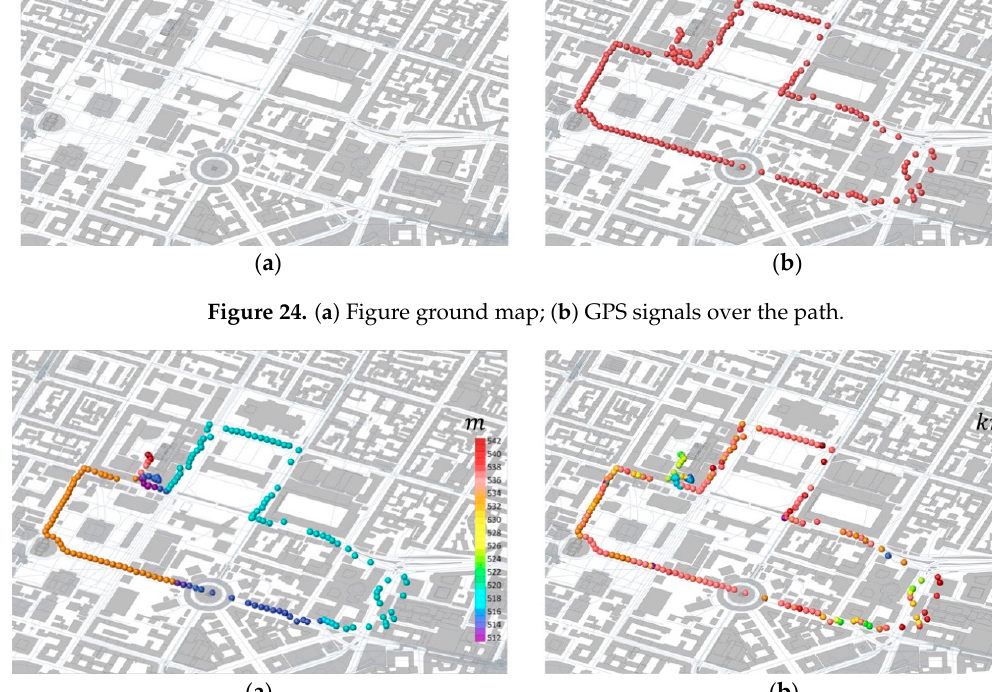
( b ) Figure 26. Transient temperature maps: ( a ) globe temperature (°C); ( b ) air temperature (°C).